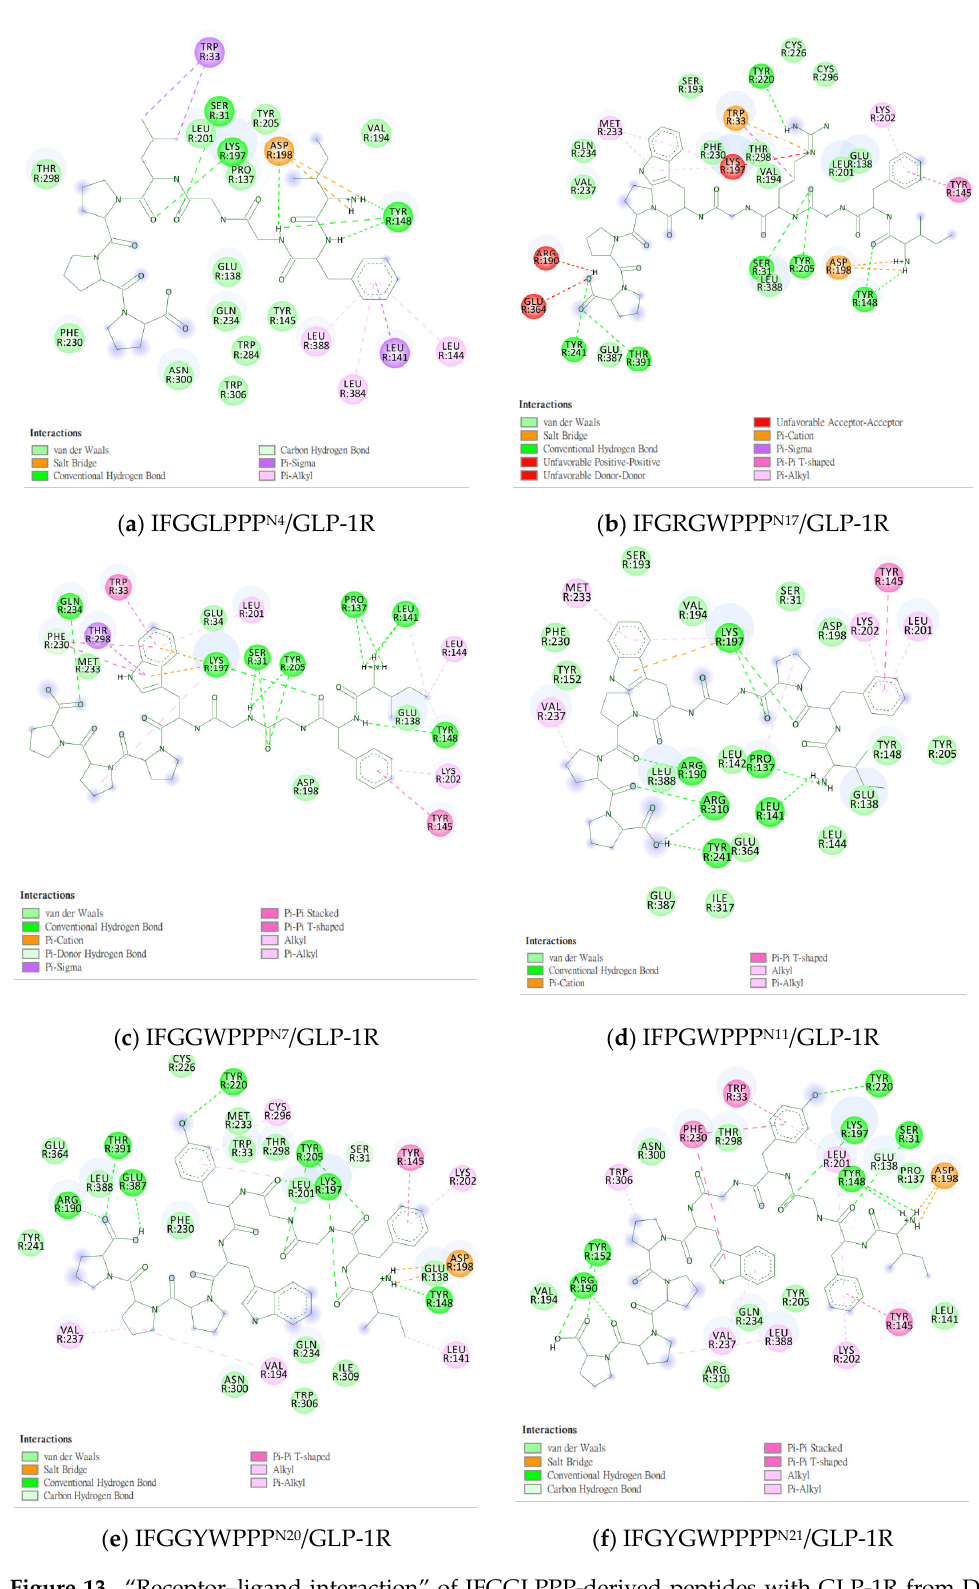
Figure 13. “Receptor–ligand interaction” of IFGGLPPP-derived peptides with GLP-1R from DS Visualizer. ( a ) IFGGLPPP N4 /GLP-1R; ( b ) IFGRGWPPP N17 /GLP-1R; ( c ) IFGGWPPP N7 /GLP-1R; ( d ) IFPGWPPP N11 /GLP-1R; ( e ) IFGGYWPPP N20 /GLP-1R; ( f ) IFGYGWPPPP N21 /GLP-1R.